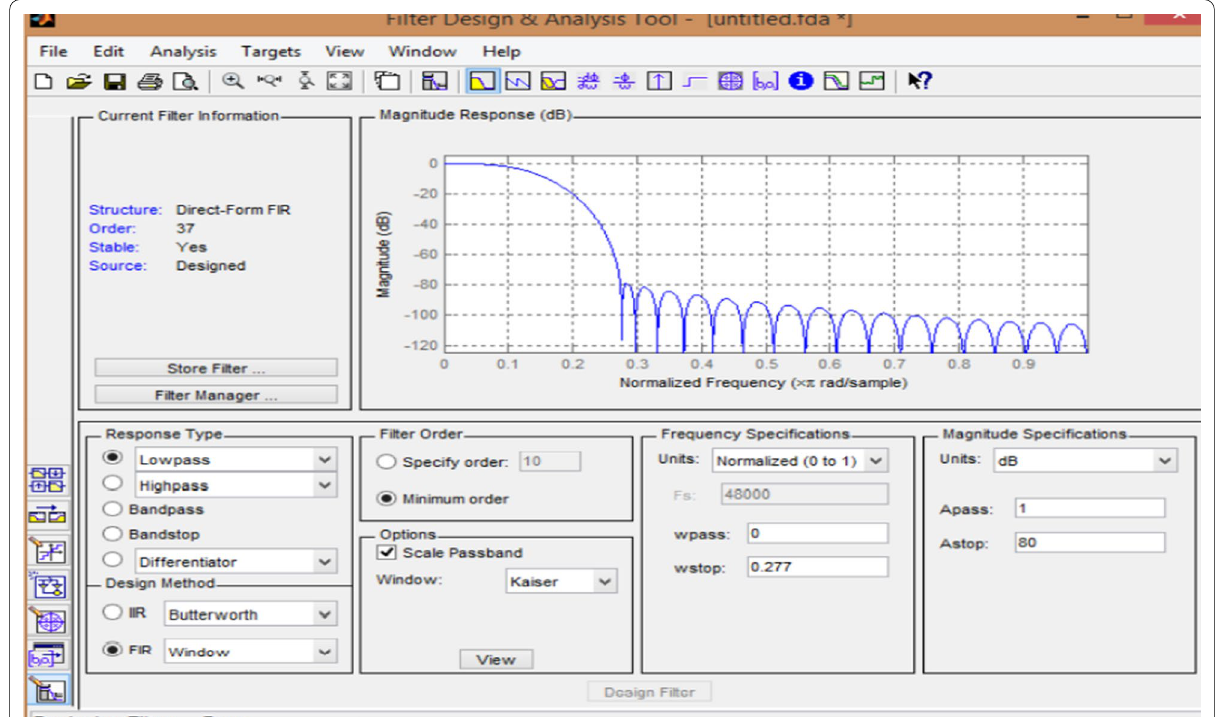
Fig. 1 FDA Tool Diagram: FDA tool is used to design a low-pass FIR filter having order 37 with the normalized cutoff frequency